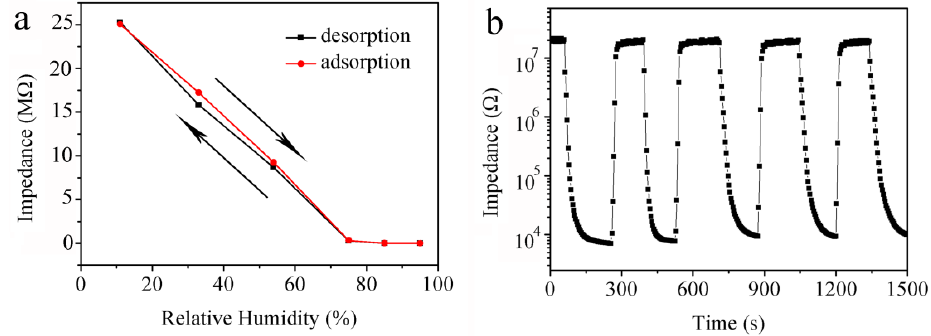
Figure 7. ( a ) Humidity hysteresis characteristics of ZnO/AuNPs nanorods (Sample 3) humidity sensor. ( b ) Response and recovery properties of ZnO/AuNPs nanorods (Sample 3) humidity